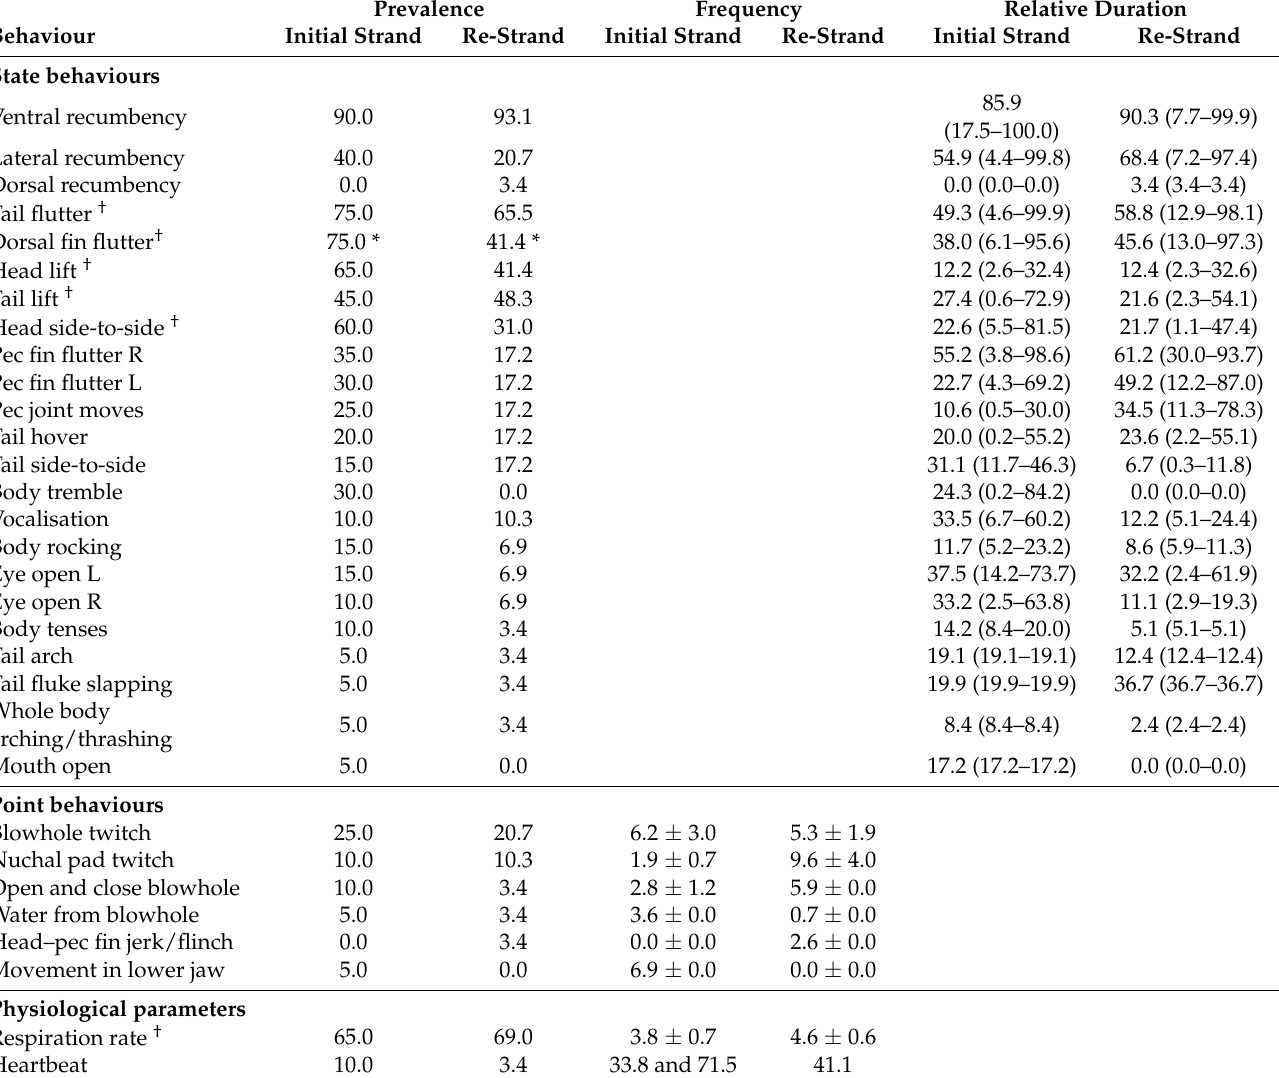
Table 4. Observed prevalence (% of individuals displaying behaviour), mean frequency (rate/minute) ± SEM of point behaviours, and mean relative duration (% of monitored time and range) of state behaviours for only long-finned pilot whales that showed the behaviour, from a total of 20 initial- stranded and 29 re-stranded individuals across 11 stranding events on the New Zealand coast between 2010 and March 2022. † Only prevalent indicators could be tested for statistical differences; * significant difference ( α = 0.05) in prevalence between stranding